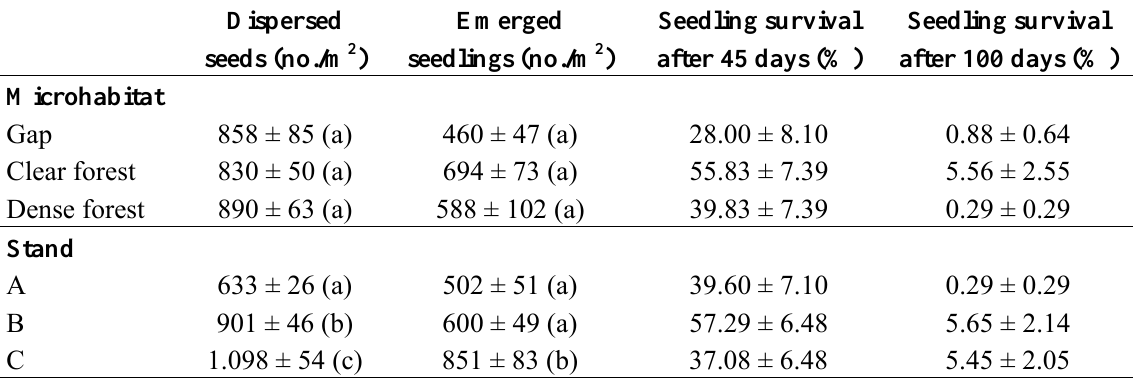
Different letters indicate significant differences in a Tukey HDS test (p <